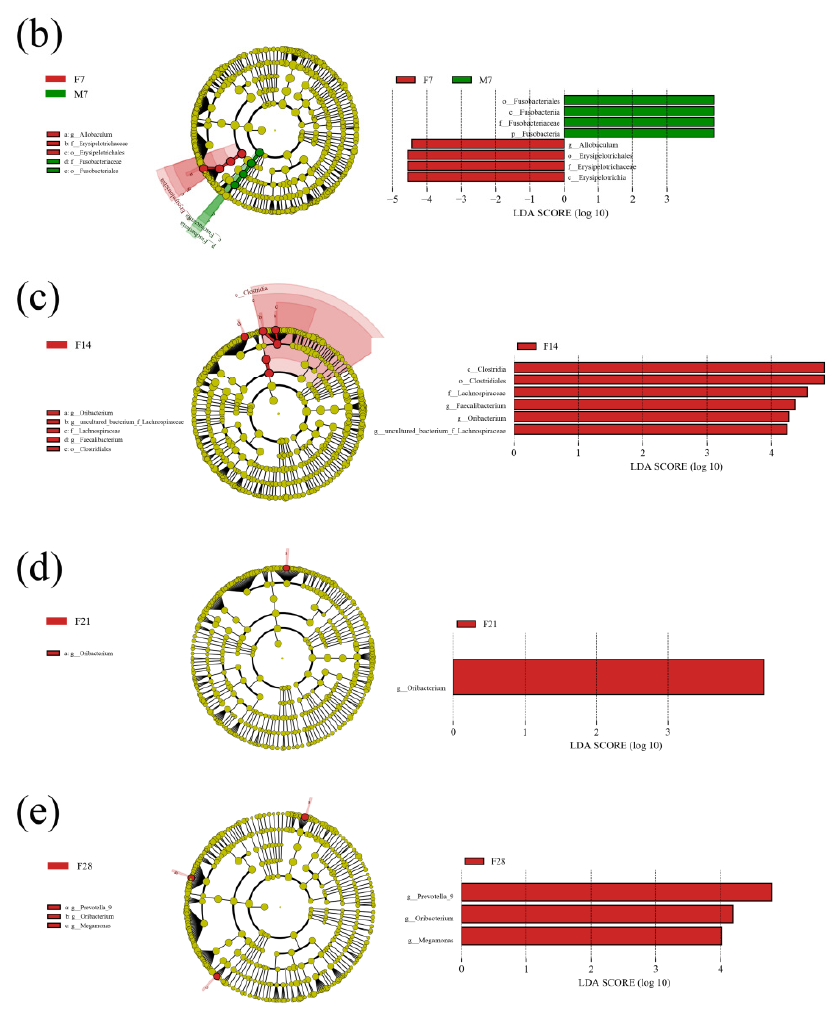
Figure 5. LDA analysis of fecal flora of two groups of blue foxes on 0 d ( a ), 7 d ( b ), 14 d ( c ), 21 d ( d ), and 28 d ( e ) of the experimental period.